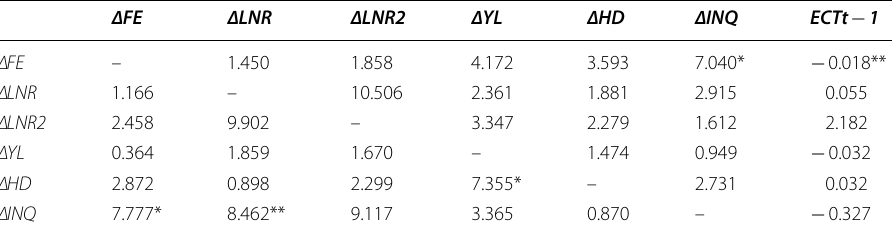
Table 11 VECM causality test